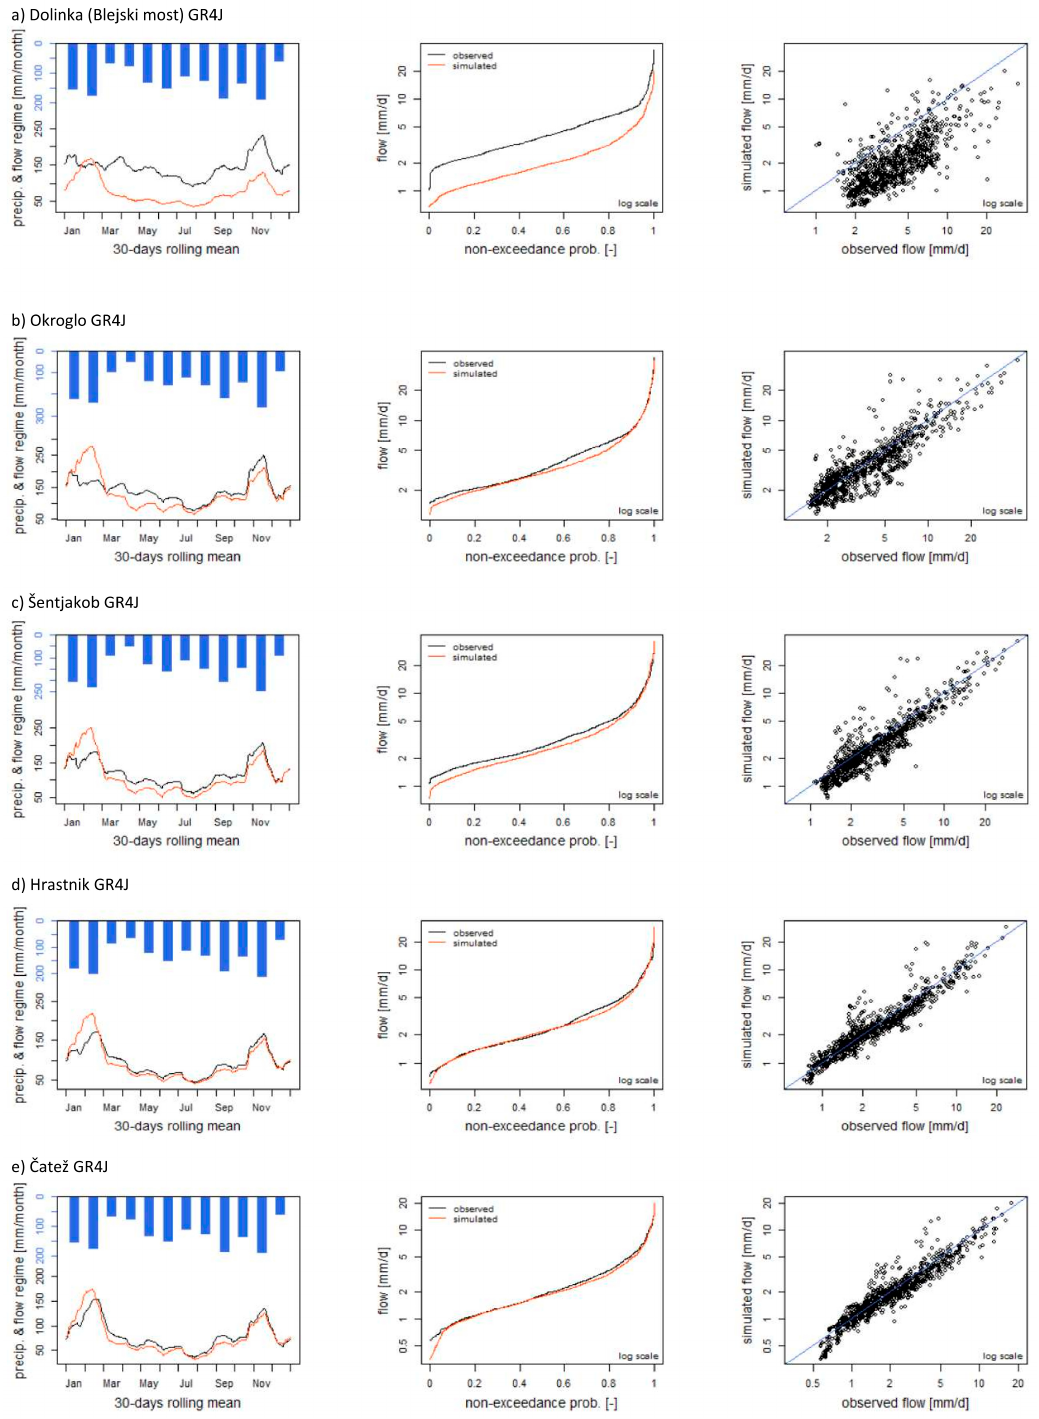
Figure 3. Evaluation of the GR4J model performance for the five nested sub-catchments in the validation period. 30-days rolling mean, flow duration curve and scatter plot in log scale are shown.